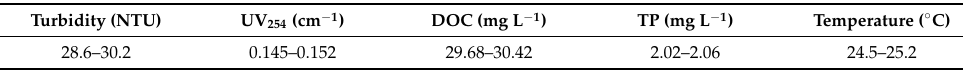
Table 1. Parameters of simulated